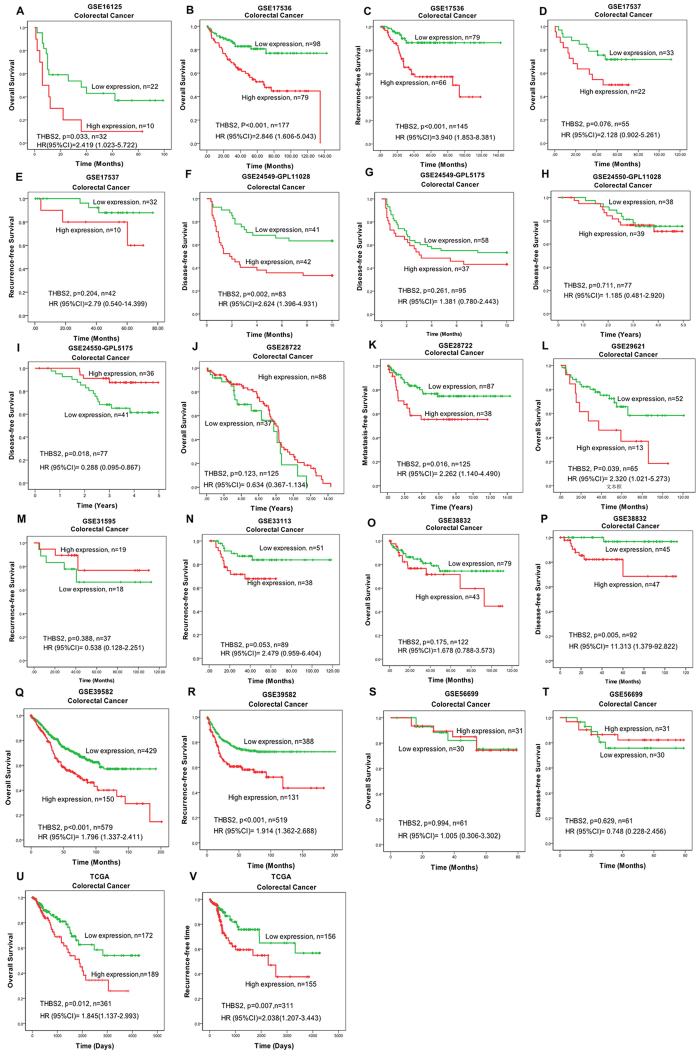
The correlation between THBS2 expression and prognosis overall survival/disease free survival were analyzed by Kaplan-Meier survival curve in GEO datasets.TheTHBS2 level was evaluation by characteristic (ROC) curve. (A) GSE16125-OS; (B) GSE17536-OS; (C) GSE17536-RFS; (D) GSE17537-OS; (E) GSE17537-RFS; (F) GSE24549-GPL11028-DFS; (G) GSE24549-GPL5175-DFS; (H) GSE24550-GPL5175-DFS; (I) GSE24550-GPL11028-DFS; (J) GSE28722-OS; (K) GSE28722-MFS; (L)GSE29621-OS; (M) GSE31595-RFS; (N) GSE33113-RFS; (O) GSE38832-OS; (P) GSE38832-DFS; (Q) GSE39582-OS; (R) GSE39582-RFS; (S) GSE56699-OS; (T) GSE56699-DFS; (U) TCGA-OS; (V) TCGA-RFS.